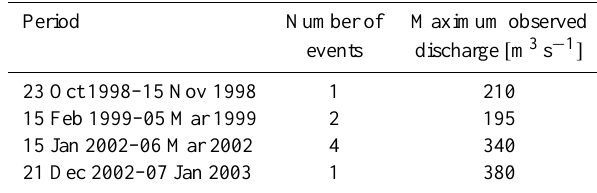
Table 1. Overview of the periods used in this study.